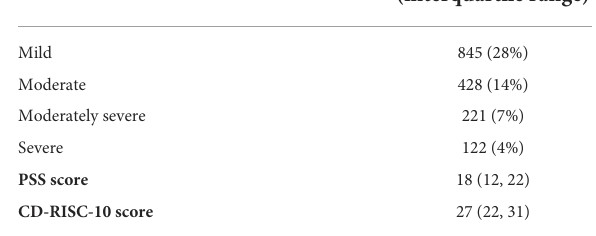
TABLE 3 Exercise behaviors, risk of eating disorders, and psychological well-being ( n = 3,022). Measure n (%) or Median